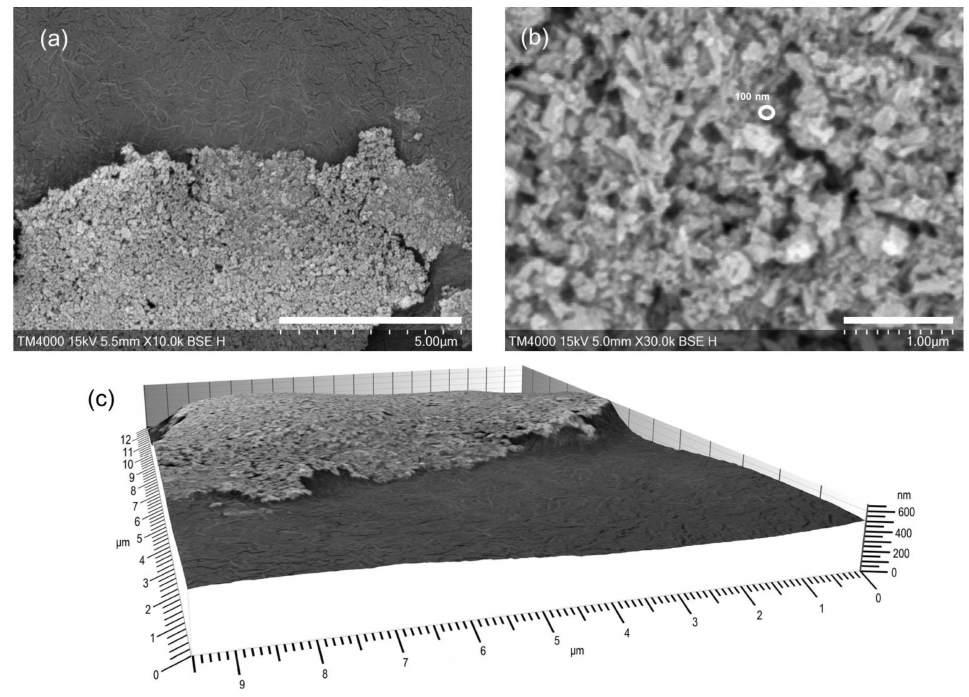
Figure 2. SEM observation of strontium apatite (SrZnSiP) coating edge after laser irradiation. ( a ) Magnification 10 × K; ( b ) magnification 30 × K; and ( c ) 3D image viewed diagonally above. Magnification 10 ×